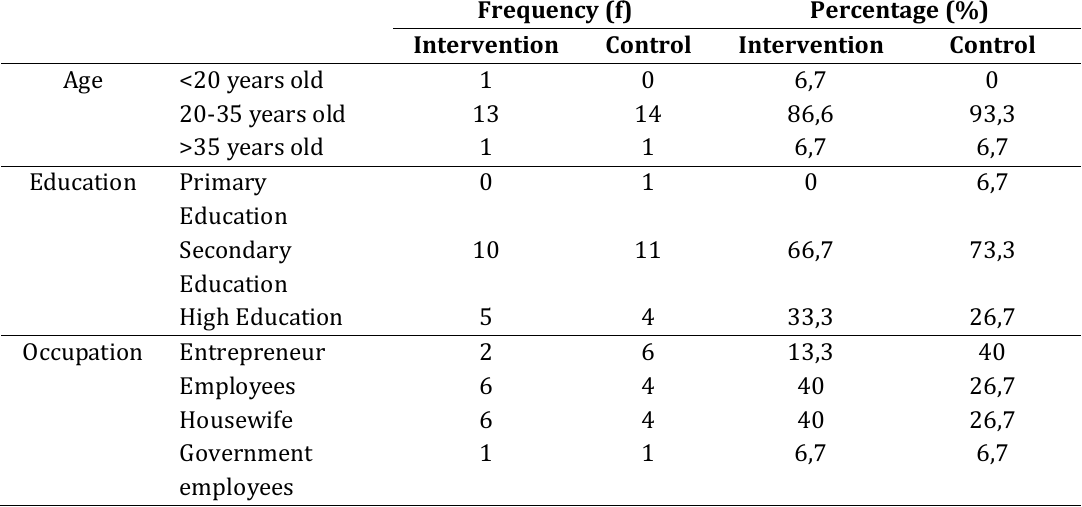
Characteristics of Respondents Based on Age, Education and Employment of primiparas in the Working Area of Public Health Centre I East Denpasar